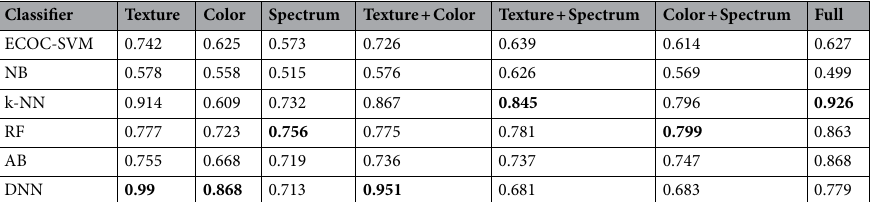
Table 2. Results of features-based psoriasis severity classification in Dataset A. The bold values indicate the best results. It shows the F1-score comparison for the six classifiers performance according to the combination of features. We created several combinations using texture, color, and spectrum, and Full is the case of using all features.